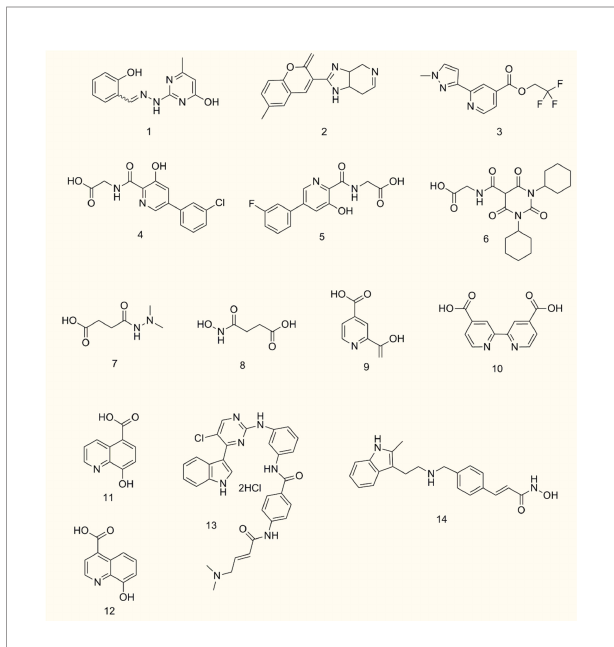
FIGURE 5 | Chemical structures of representative JMJD6